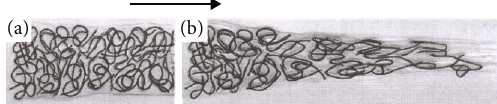
Figure 1: Scheme of transformation of an isotropic amorphous polymer in the process of gradient stretching (transformation of a statistical coil): (a) isotropic polymer fi lm and (b) the same fi lm gradually stretched. The arrow indicates the direction of propagation of the extension